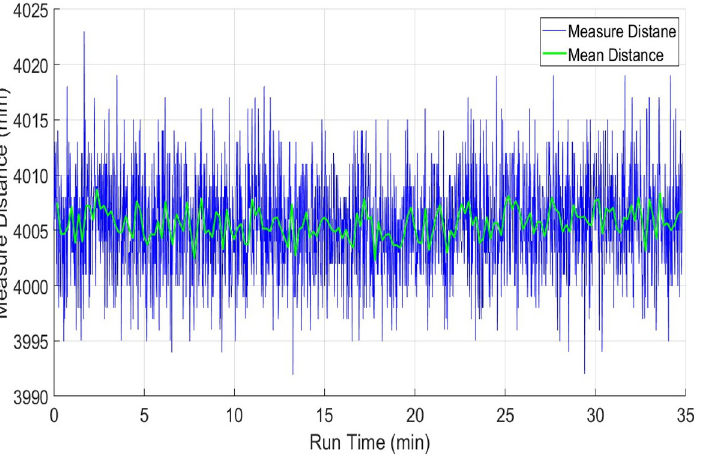
Fig 11. Drift test of UTM-30LX using range measurements of four-meter distance.